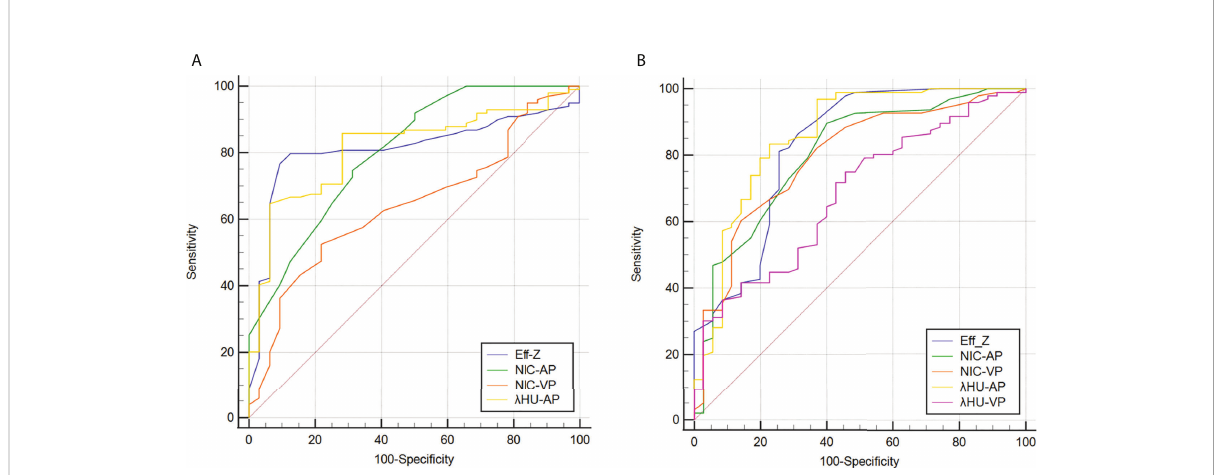
FIGURE 5 Receiver operating characteristic curves for predicting high-grade (A) and advanced-stage and (B) CRAC. Details of the area under the curves of each metric are shown in the results section. CRAC, colorectal